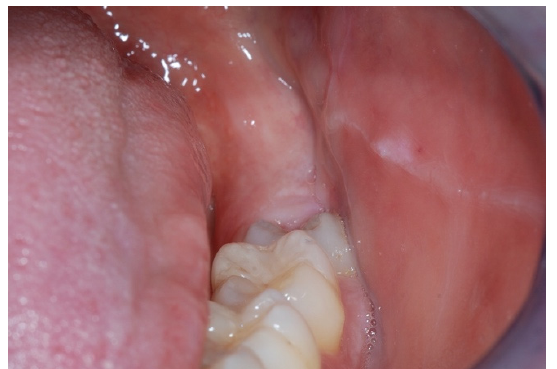
Figure 2. Severe linea alba of the cheek mucosae, which is a potential sign of prolonged bruxism activity in the form of bracing and/or clenching.